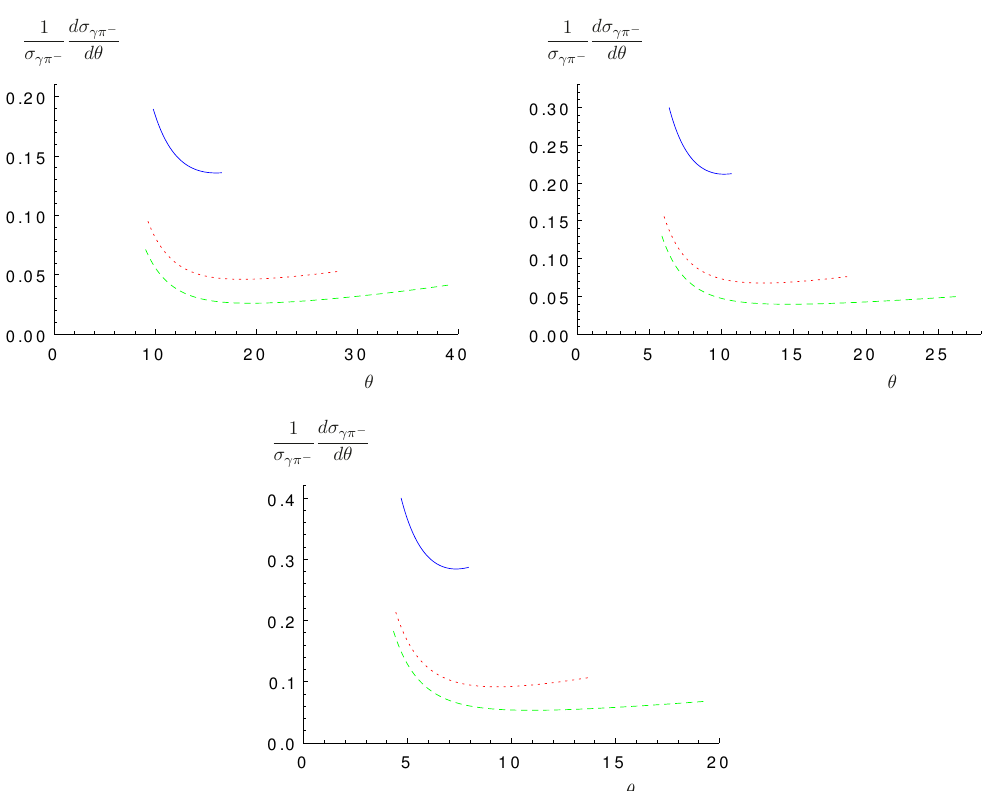
Figure 14 . Angular distribution for γπ − pair production on a neutron target. Up, left: S γN = 10 GeV 2 . Up, right: S γN = 15 GeV 2 . Down: S γN = 20 GeV 2 . In all three cases, the plots are shown for M 2 = 2 GeV 2 (solid blue), M 2 = 3 GeV 2 (dotted red) and M 2 γπ − γπ − (dashed